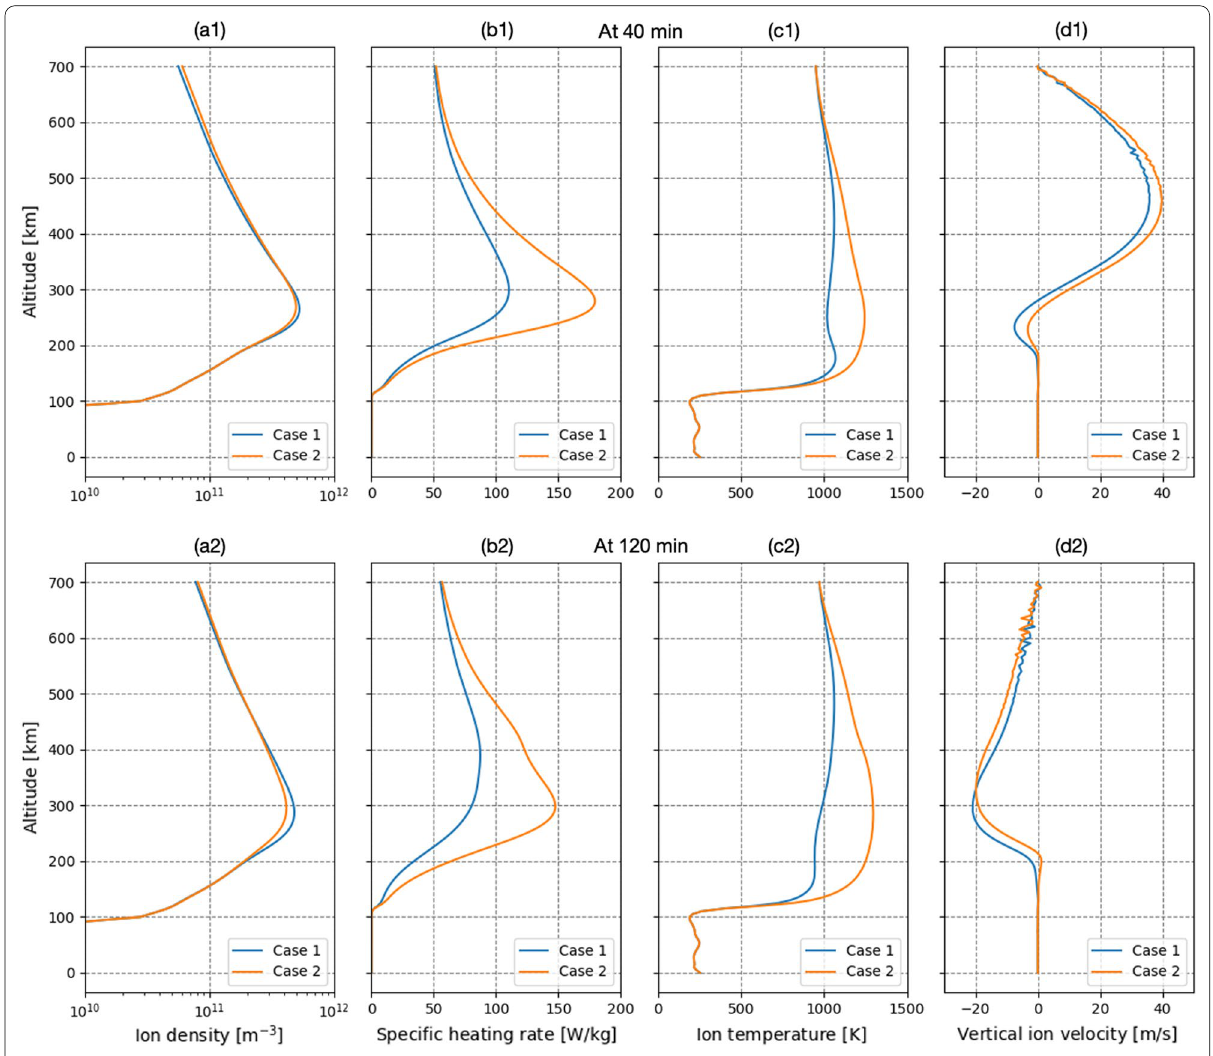
Fig. 5 The resulting profiles of the ion density (left), specific heating rate (middle left), ion temperature (middle right), and vertical ion velocity (right) at 40 min (top) and 120 min (bottom) intervals in each